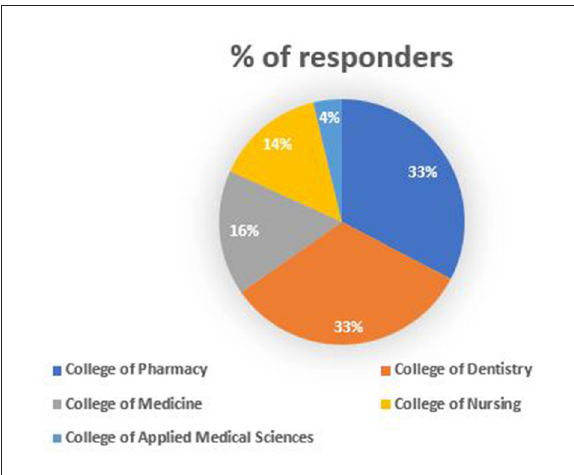
FIGURE1 Proportion of responders from each health